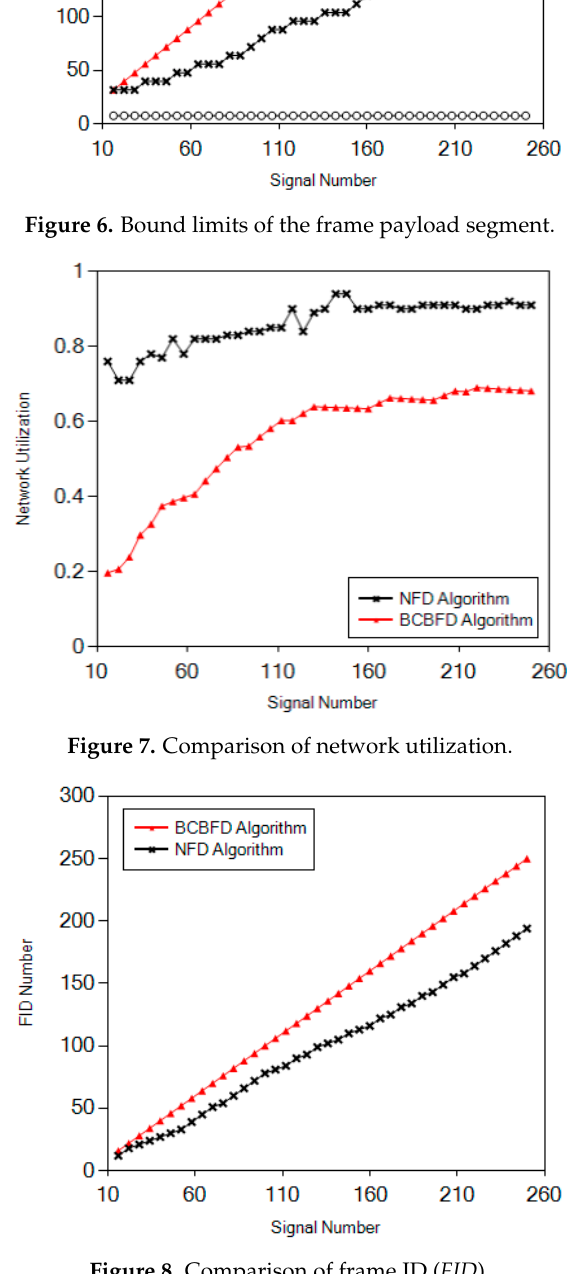
Figure 8. Comparison of frame ID ( FID ).